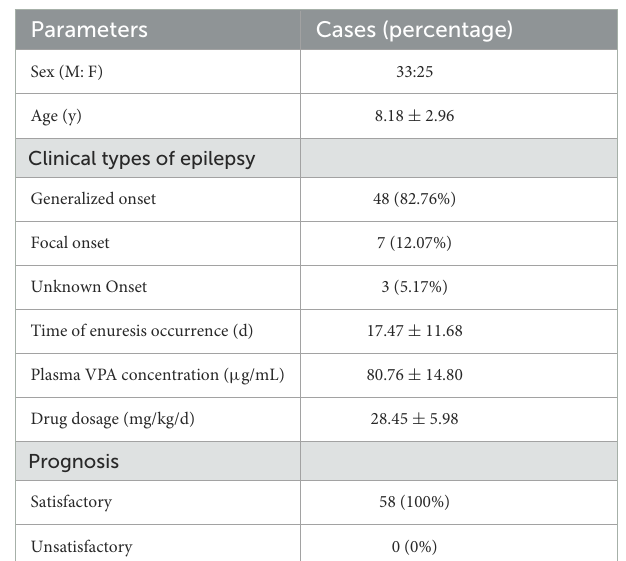
TABLE 3 Analysis of all the presented